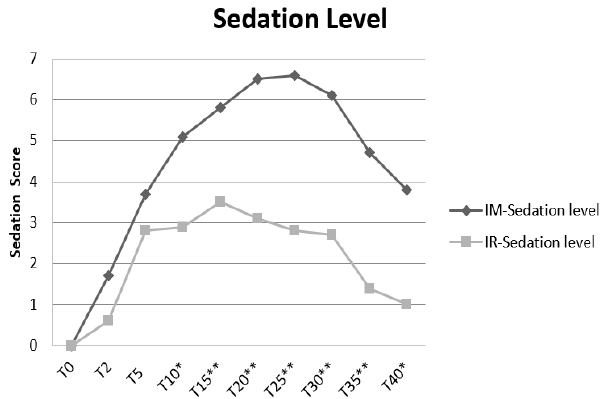
Figure 1. Trend of sedation levels in intrarectal (IRG) and intramuscular group (IMG). The table shows the trend of sedation curve during the time of procedure. Sedation score is along the